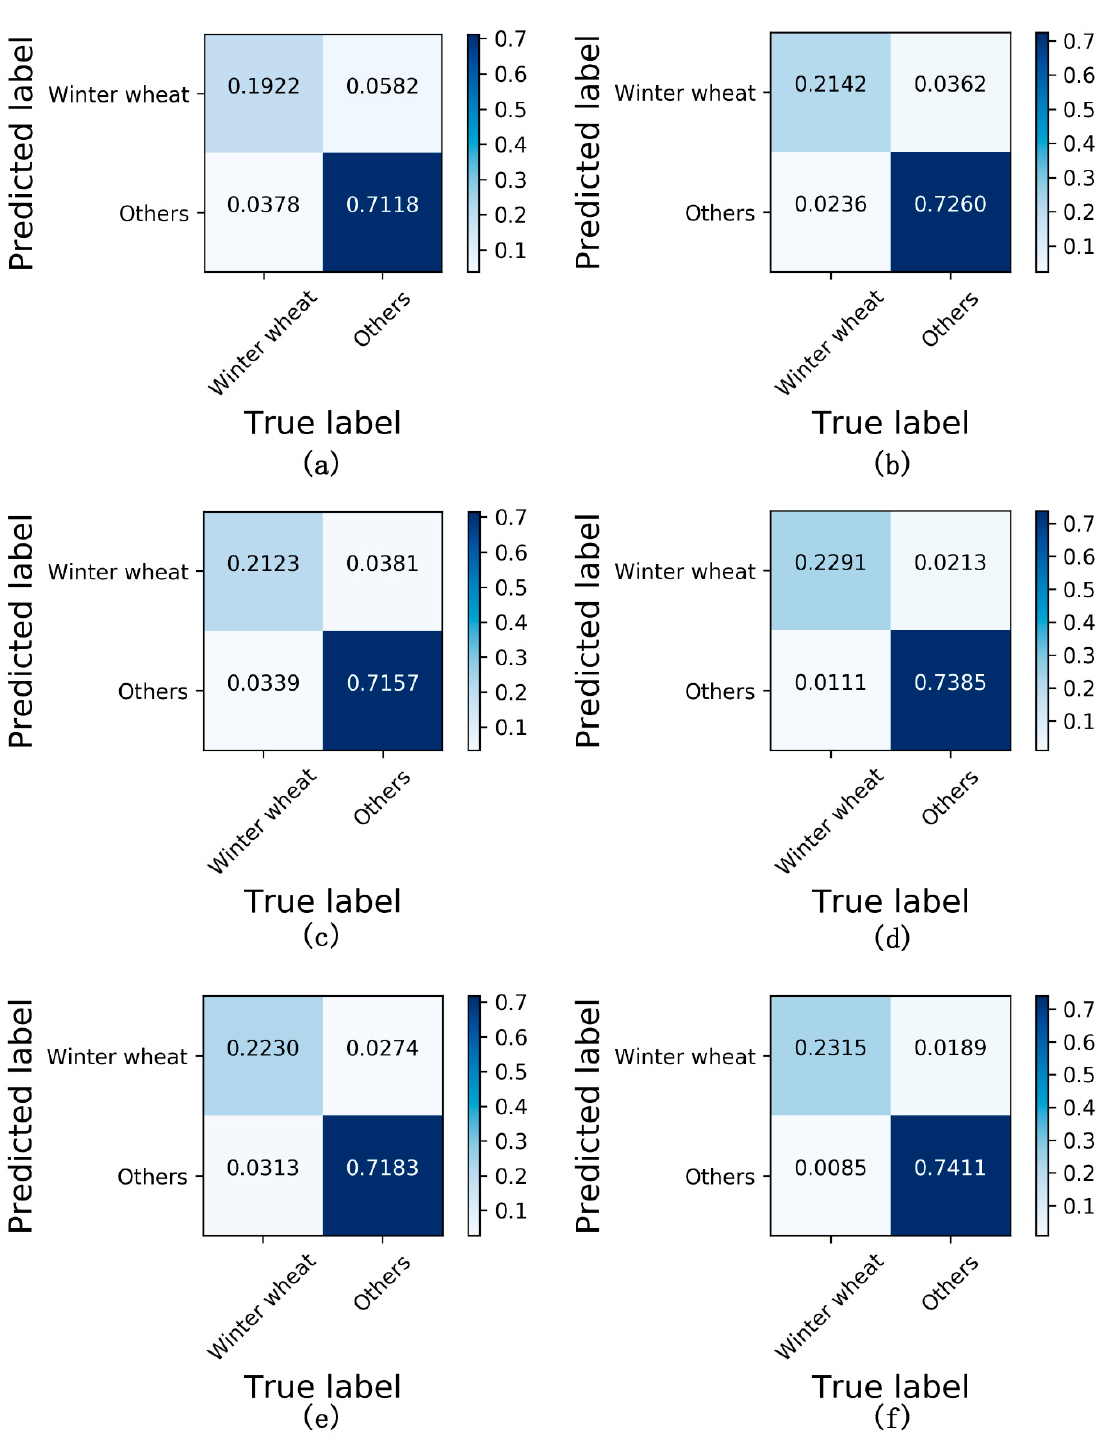
Figure 9. Confusion matrices of the different models using the GF-2 image datasets: ( a ) SegNet, ( b ) SegNet-CRF, ( c ) SegNet-PCCRF, ( d ) RefineNet, ( e ) RefineNet-CRF, and ( f ) RefineNet-PCCRF.